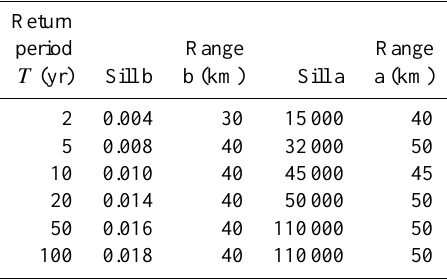
Table 3. Adjusted sills and ranges for a(T ) and b(T ) assuming spherical variogram models.